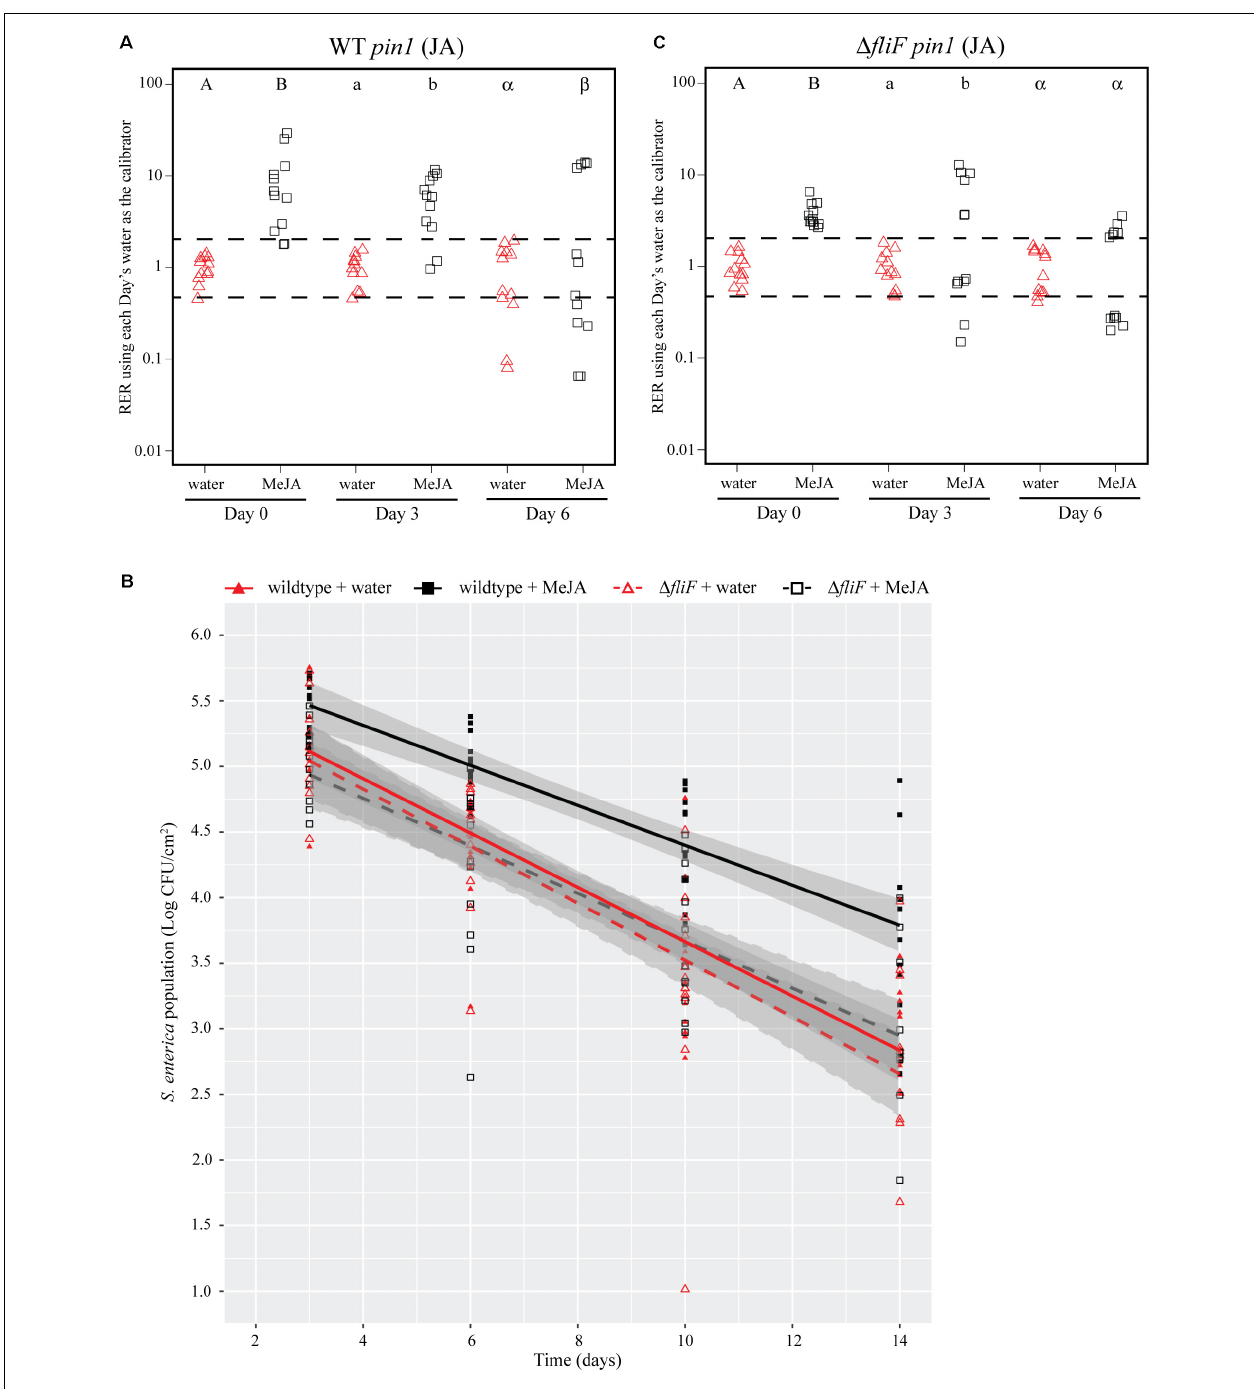
FIGURE 4 | Induction of the JA response with a chemical analog increases S. Typhimurium survival over time. (A,C) Plant pin1 gene expression was quantified at days 0, 3, and 6 post-inoculation with wildtype S. Typhimurium (A) or the fliF ::Kan mutant (C) for plants sprayed with water (red triangles) or methyl jasmonate (MeJA; black squares) and displayed as relative expression ratios (RER) using transcription on plants treated with water as the calibrator. The dashed line indicates a twofold change in transcription, and each symbol represents data collected from one tomato plant. Transcript levels were quantified from three biological replicates with samples taken from four plants per treatment per time point. Letters denote significant differences between treatments within a single time point ( P < 0.05). (B) Bacterial populations on leaves were monitored over time following either treatment with water (red triangles) or MeJA (black squares) 24 h prior to bacterial dip inoculation. All data points from three independent experiments were combined and presented as S. Typhimurium populations (log CFU/cm 2 ) over a 14-day period. Lines (red, solid: wildtype S. enterica after water treatment; black, solid: wildtype S. Typhimurium after MeJA treatment; red, dashed: fliF ::Kan after water treatment; black, dashed: fliF ::Kan after MeJA treatment) correspond to a linear regression model, and shaded areas correspond to the respective 95% confidence interval.